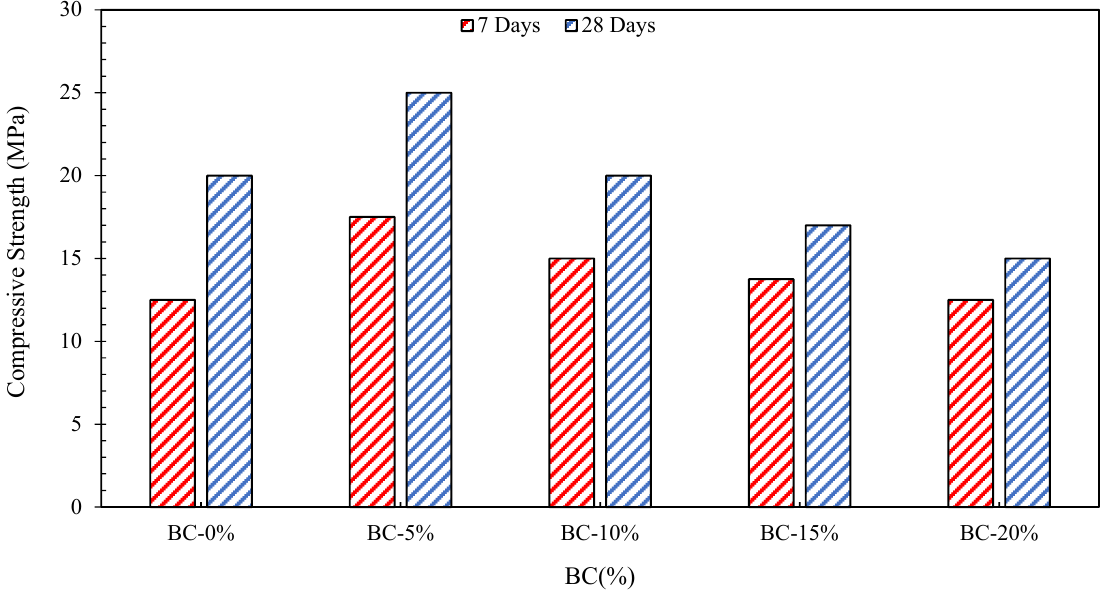
Figure 10. Flexure strength